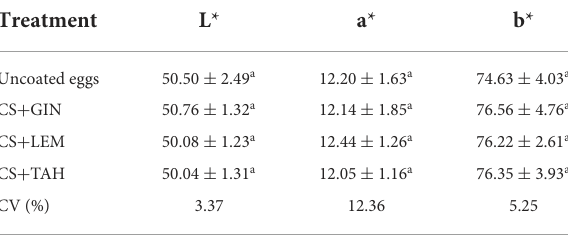
TABLE 4 Yolk color of the different treatments during the 35th day of storage at 20 ◦ C.